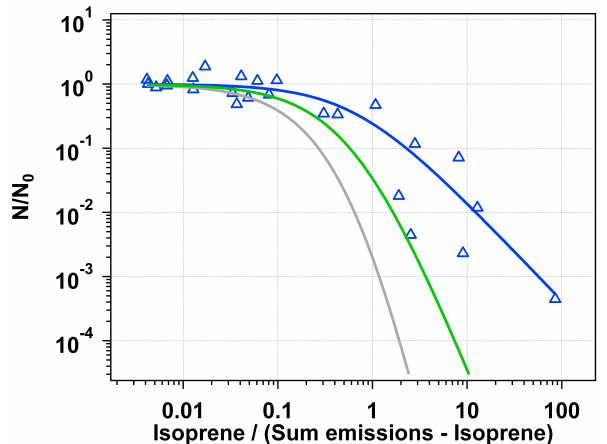
Fig. 2. N/N 0 as function of isoprene relative contribution to total VOC emissions for all poplar experiments (blue symbols, [ppbC]/[ppbC]). Fitting the data with (1/(1+1.5*R)) n results in n of 1.6 ( ± 0.6 SD) (blue line) which is significantly lower than the 3.7 ( ± 0.4 SD) observed for mixed forests with MT dominated emis- sions and 6.8 ( ± 0.5 SD) for α -pinene (green and grey lines, respec- tively, adapted from Kiendler-Scharr et al. (2009b)).